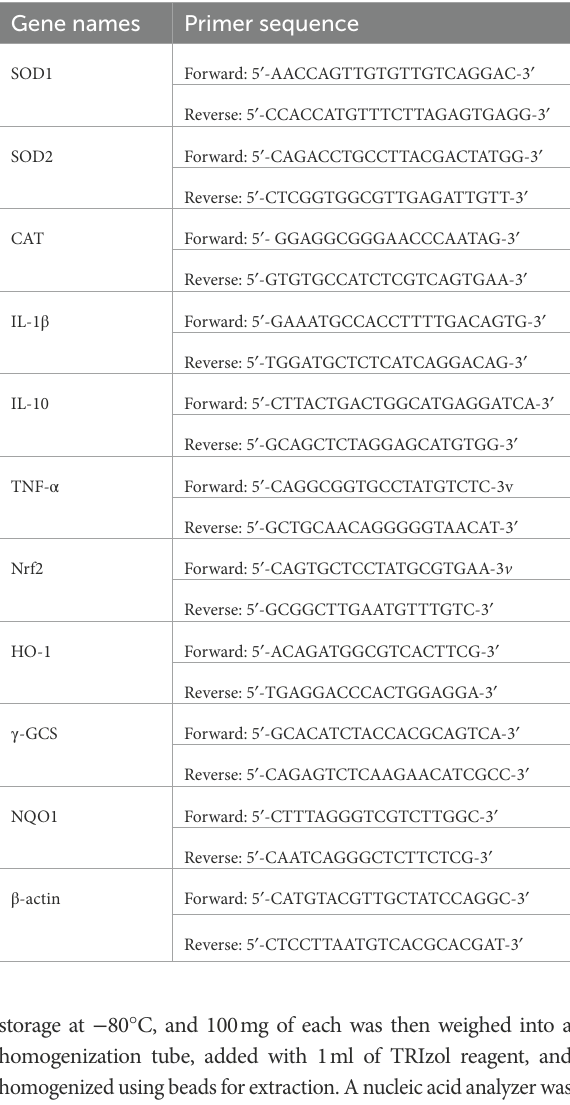
TABLE 1 Primer sequences used in the real-time quantitative